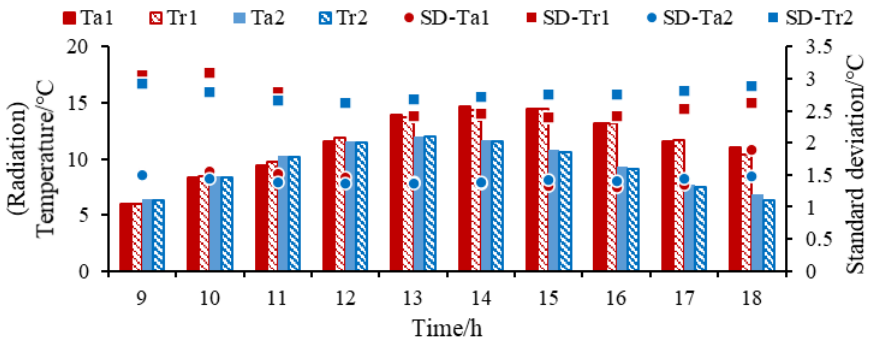
Figure 14. The average temperature and corresponding SD on a horizontal plane at the height of 0.6 m.